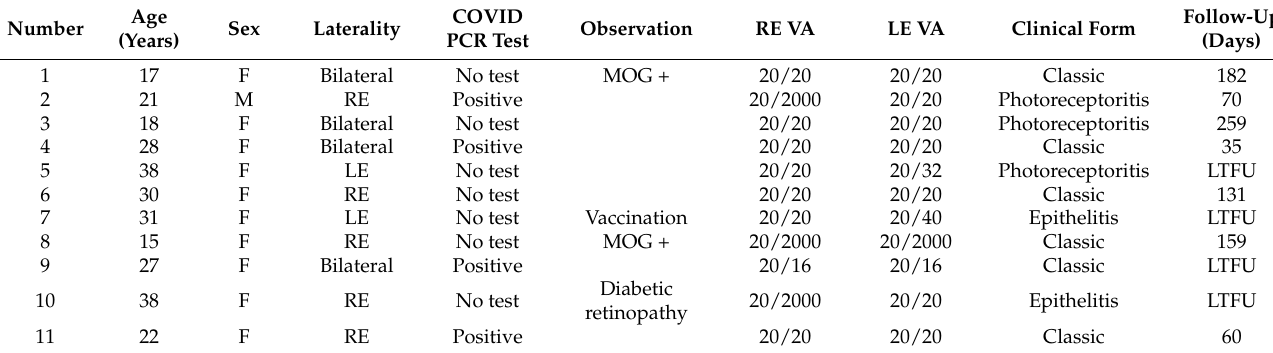
Table 2. Baseline characteristics of